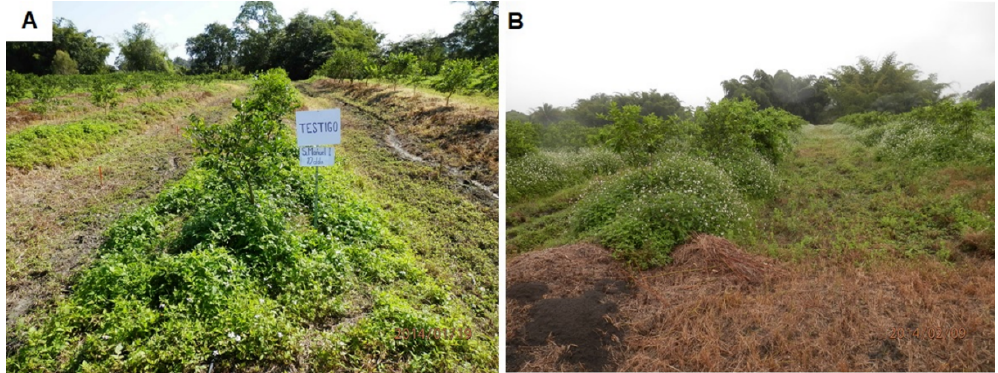
Figure 4. Persian lime rows infested with B. pilosa in “San Manuel I”, Acateno, Puebla, in 2014. ( A ) Untreated control plot 10 DAT, and ( B ) random rows at 30 DAT. Persian lime trees were 3 years old.